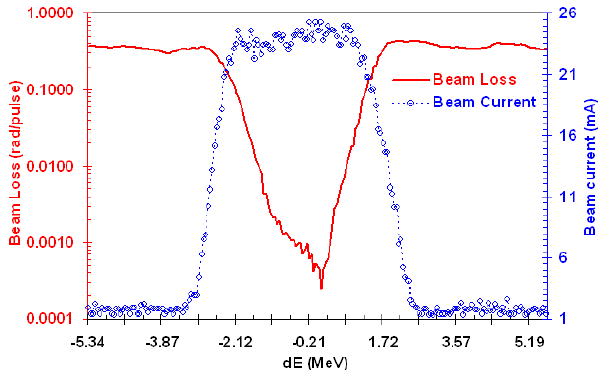
FIG. 9. (Color) The BCM signal and the total beam loss mea- sured with all SCL BLMs in a beam energy scan.